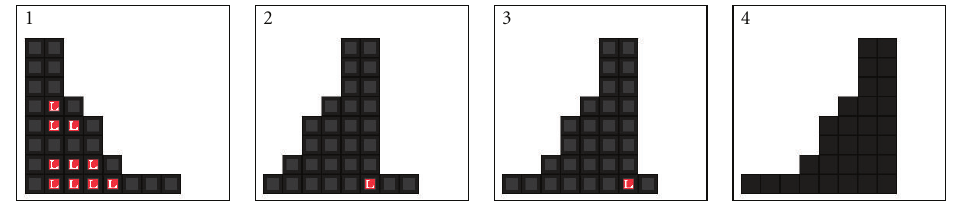
Figure 9: Simulation result of transformation process.